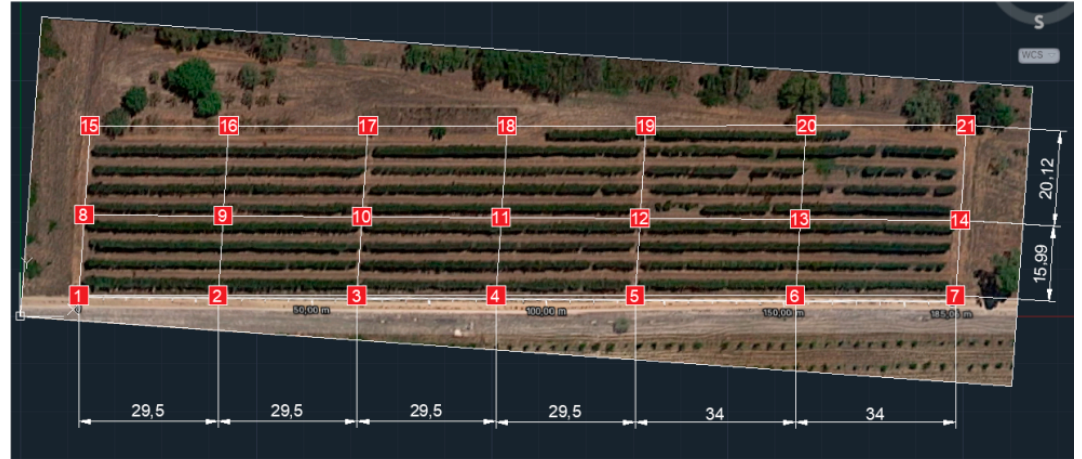
Figure 4. Ground control point (GCP) positions and field size of the experimental olive orchard.